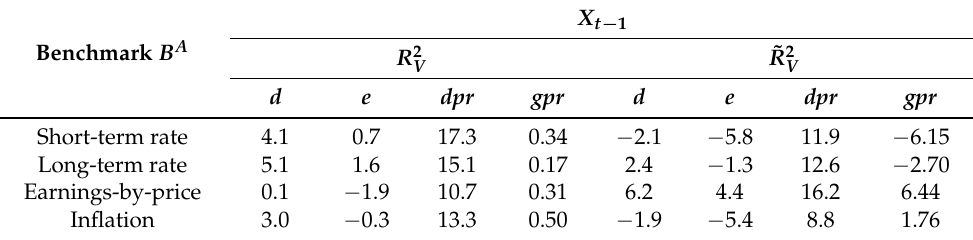
Table 3. Predictive power for the one-year excess stock returns Y defined in (2). The predictive power (%) is measured by R 2 B ( A ) considered are based on the short-term interest rate ( A ≡ R ), long-term interest rate ( A ≡ L ), earnings-by-price ratio ( A ≡ E ), and consumer price index ( A ≡ C ). The predictive variables X t − 1 used are given by dividend-by-price ratio d t − 1 , earnings-by-price ratio e t − 1 , debt-by-price ratio dpr t − 1 and GDP-by-price ratio gpr t − 1 . The predictive power (%) for the one-year stock returns ln S t validated on the original scale without benchmark is measured by ˜ R 2 back-transformed stock return prediction (cid:100) ln S t defined in (4). The sample period is 1947–2020.